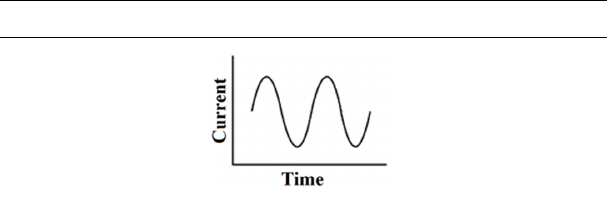
FIGURE 5 | Continuous 1-co-sinusoidal